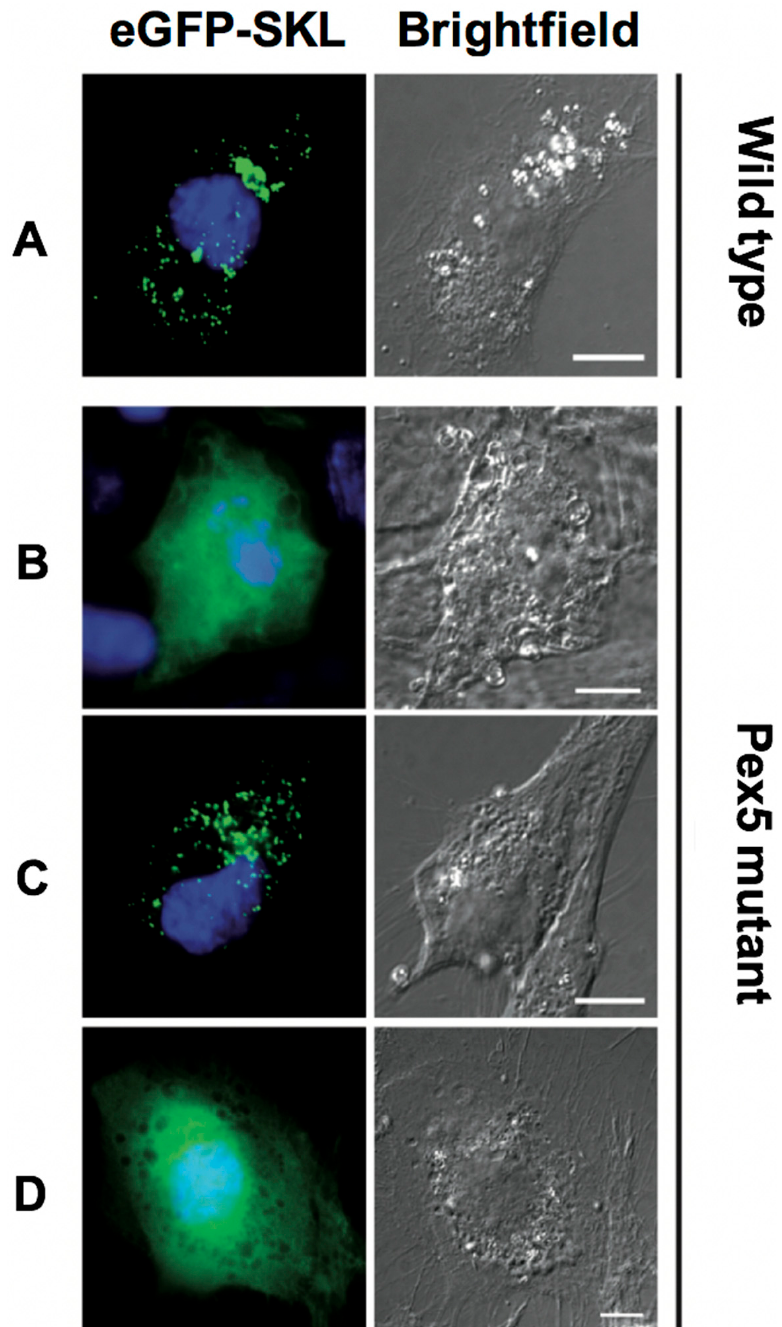
Figure 2. Tg Pex5 does not functionally replace Pex5 function in human fibroblast cells. In wild-type cells ( A ), peroxisomal reporter enhanced (e) GFP-SKL is imported into peroxisomes, resulting in a characteristic punctuate pattern. In Pex5 mutant cells ( B , negative control), eGFP-SKL is mislocalised to the cytosol, resulting in the diffuse cytosolic pattern of GFP. Co-expression of human Pex5 ( Hs Pex5L, C , positive control) restored the localisation of eGFP-SKL to peroxisomes. In contrast, co-expression of Tg Pex5 ( D ) did not localise eGFP-SKL to peroxisomes. Scale bar is 10 µm.